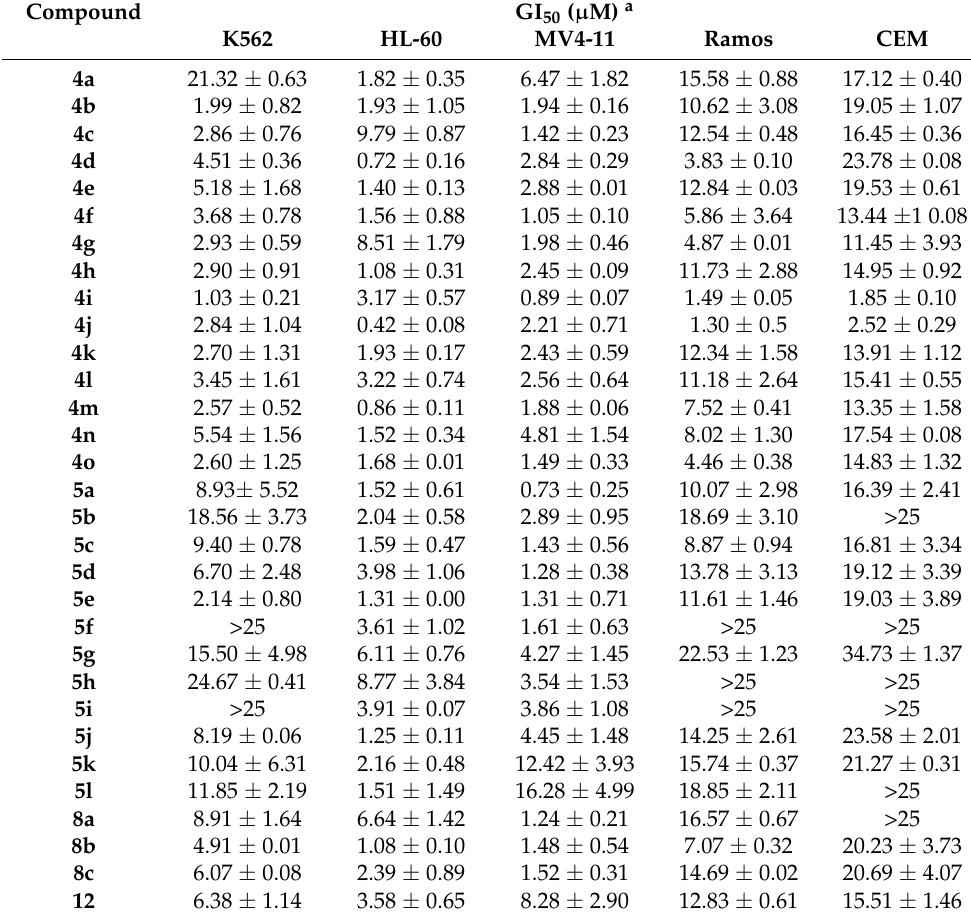
Table 3. The in vitro cytotoxicity of compounds 4a – o , 5a – l , 8a – c and 12 on cancer cell lines.